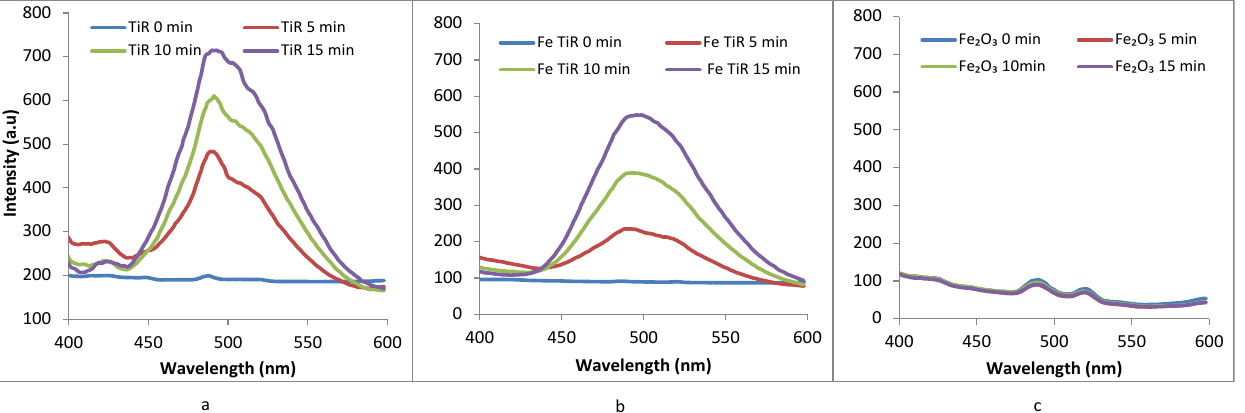
Figure 5. · OH radicals trapping by coumarin under solar irradiation over TiR ( a ), FeTiR ( b ) and Fe 2 O 3 ( c ).